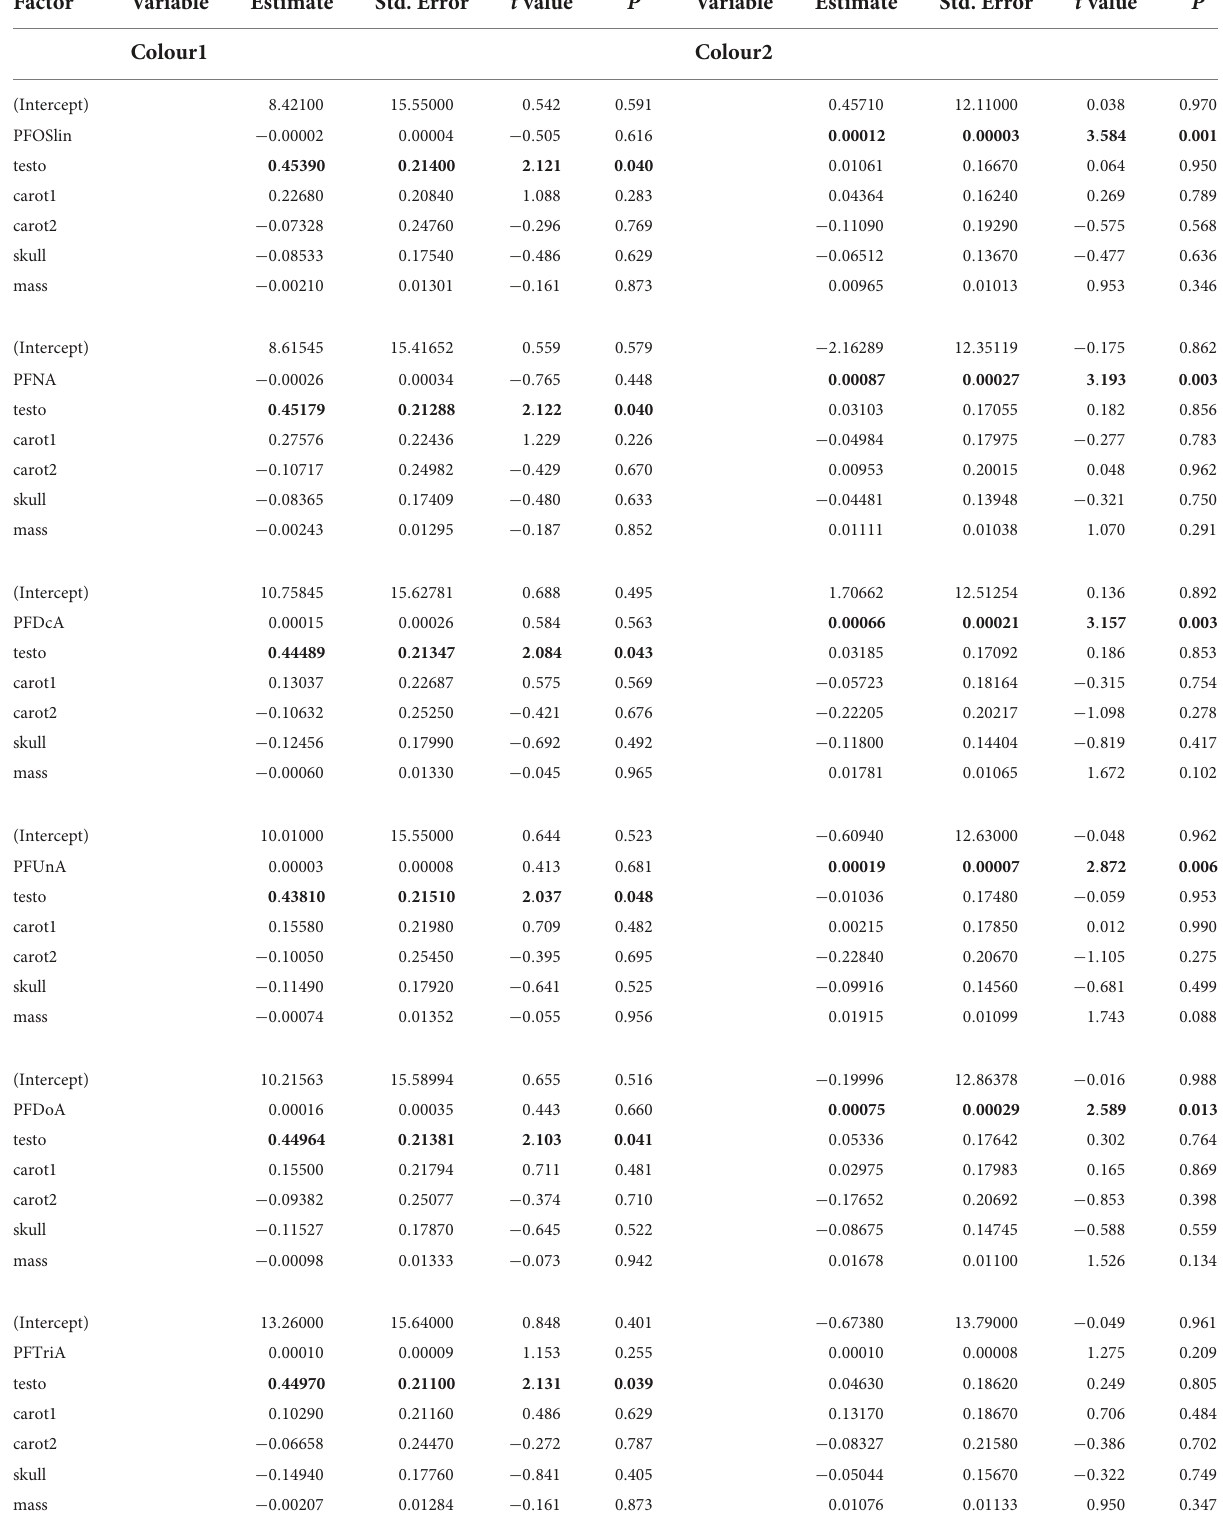
TABLE 1 Outcomes of lme models testing the effects of contaminants on colorimetric variables.